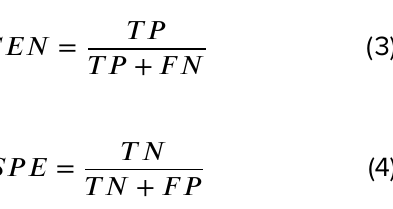
resolution of the OCT system. In our study, the axial resolution was 2.8